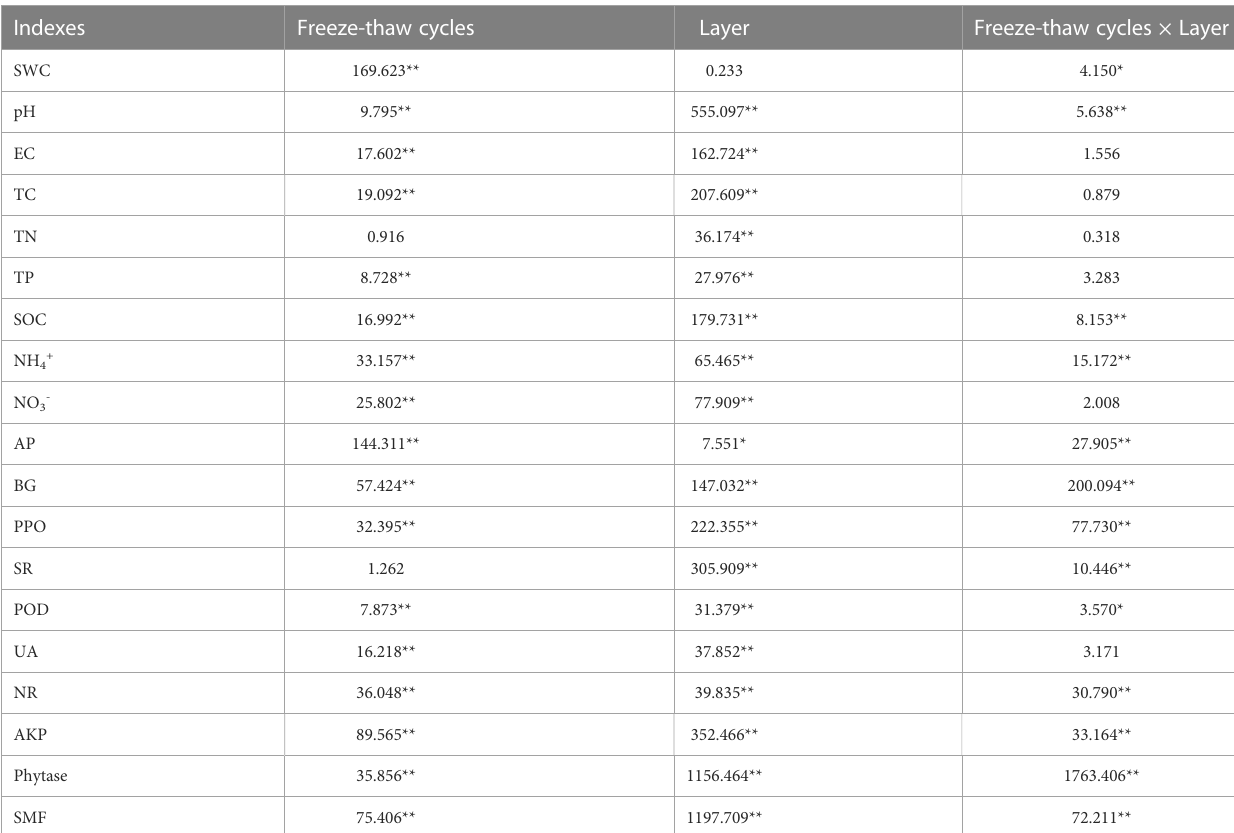
TABLE 1 Two-way analysis of variance for physicochemical properties of the soil.